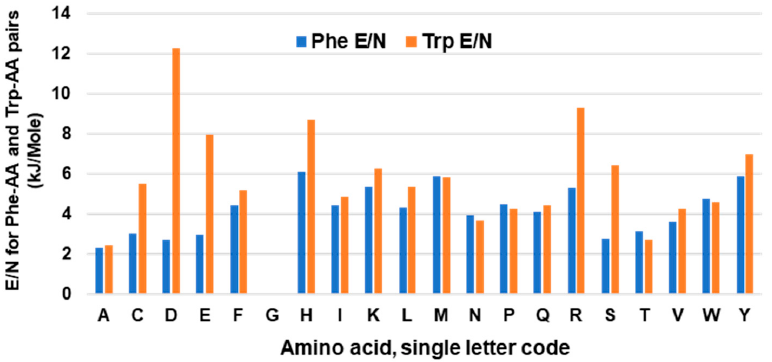
Figure 5. Average energy per interacting pair of amino acids. Energy of interaction of Trp or Phe with other amino acids were collected from multiple proteins, and the total energy (E) of a pair was divided by the total number of the pair (N) and plotted, as described in Section 6.2. Note the absence of values for Phe–Gly and Trp–Gly as Gly lacks a side chain.